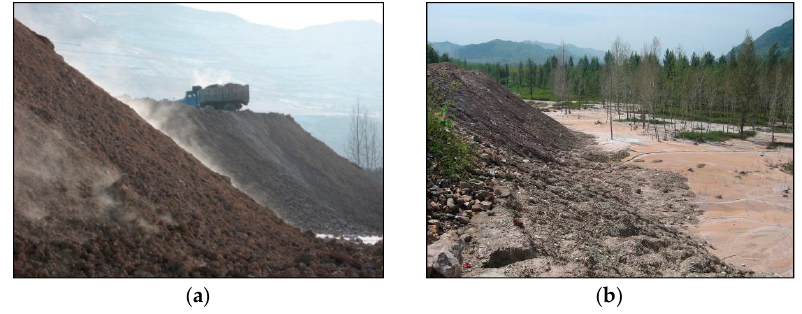
Figure 1. Effects of boron waste on the environment. ( a ) Air storage; ( b ) Waste diffusion.